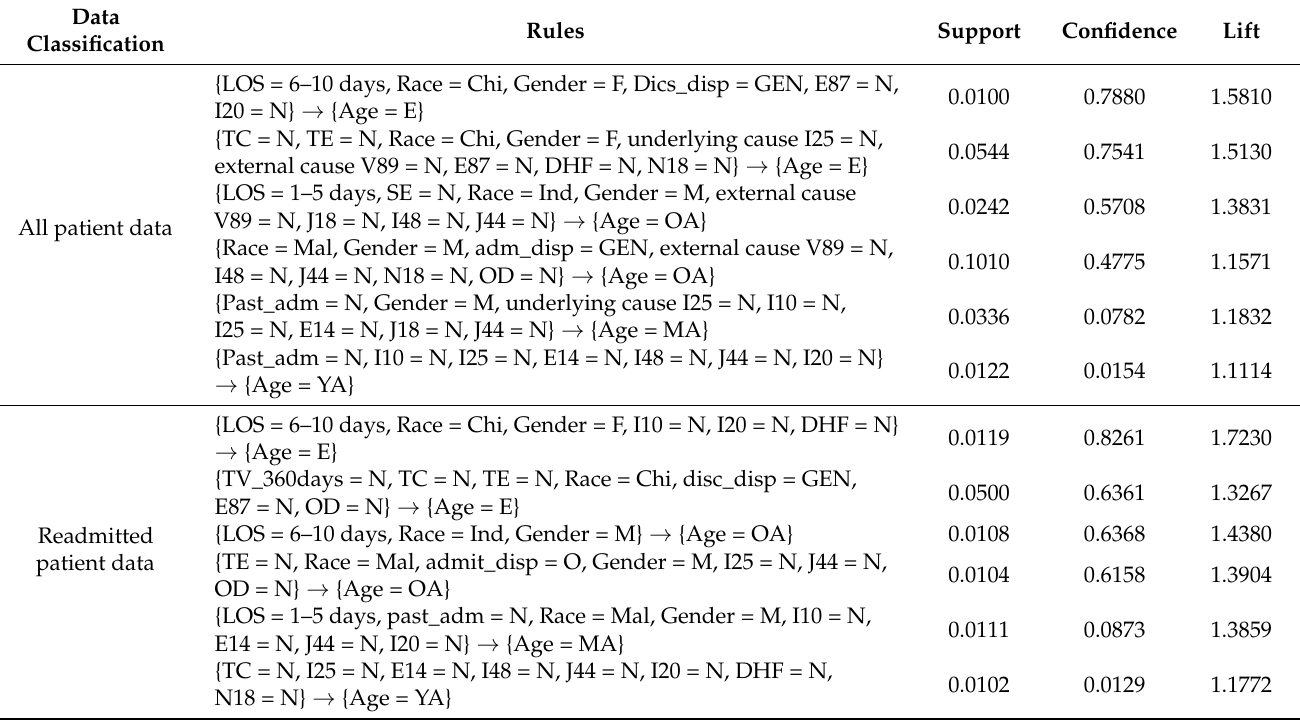
Table 6. Supervised association rule mined based on age